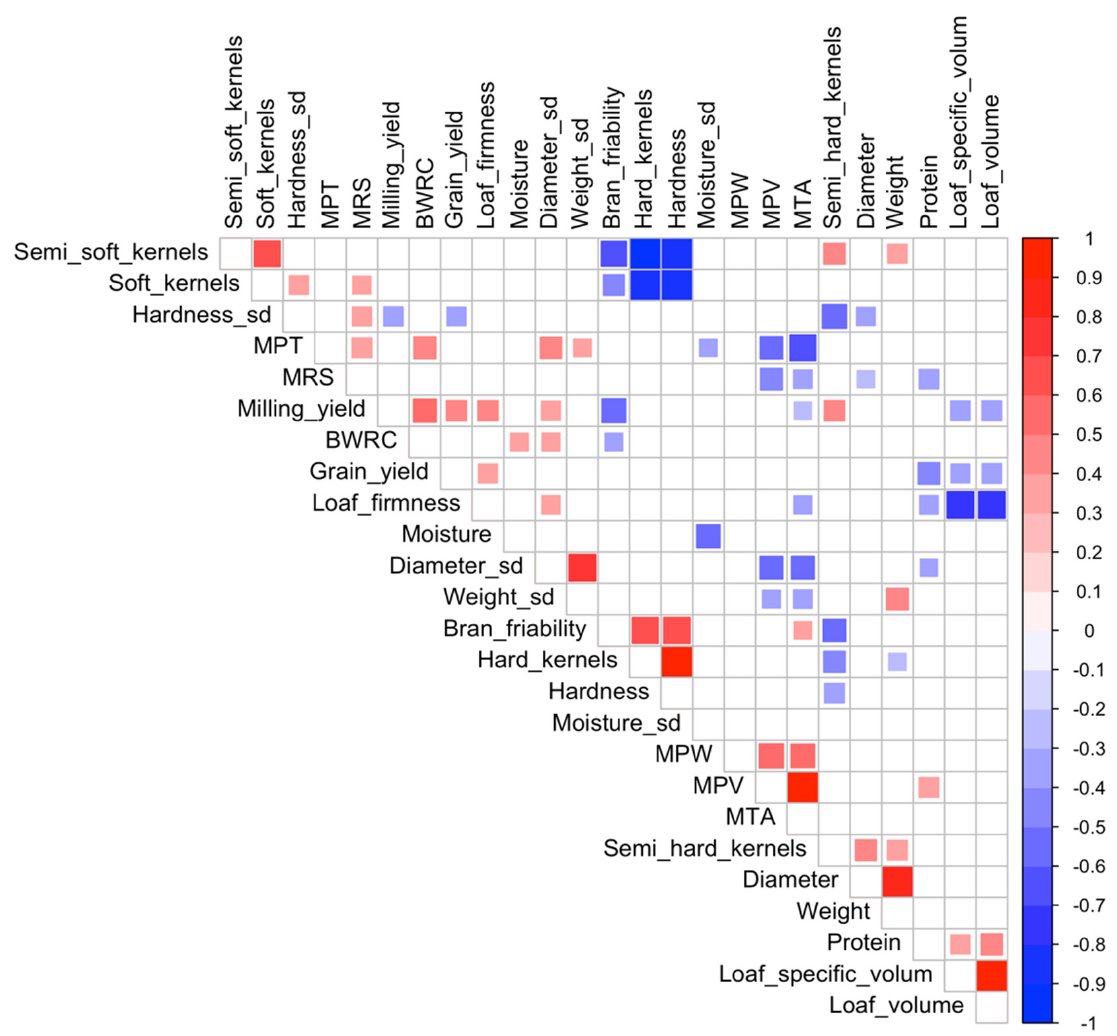
Figure 5. Partial correlation between each variable. Partial variable was harvest year, and plant height. Least-squares means in each harvest year were used in the correlation ( n = 46). Only significant correlations are plotted ( p < 0.05). (MPW: Midline peak width; MPV: Midline peak value; MTA: Midline time max area; MPT: Midline peak time; MRS: Midline right slope; BWRC: Bran water retention capacity).